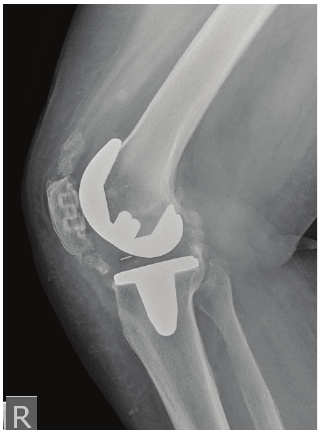
Figure 2: Postoperative radiographs of the total knee replacement at 8 months showing the severe heterotopic ossification.